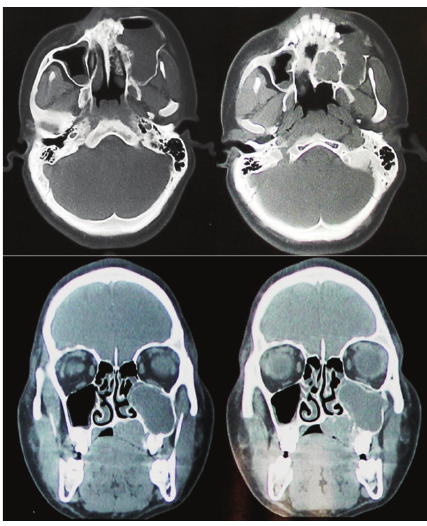
Figure 3: Axial and coronal CT views showing large osteolytic lesion/s involving left maxilla with continuity of buccal and palatal